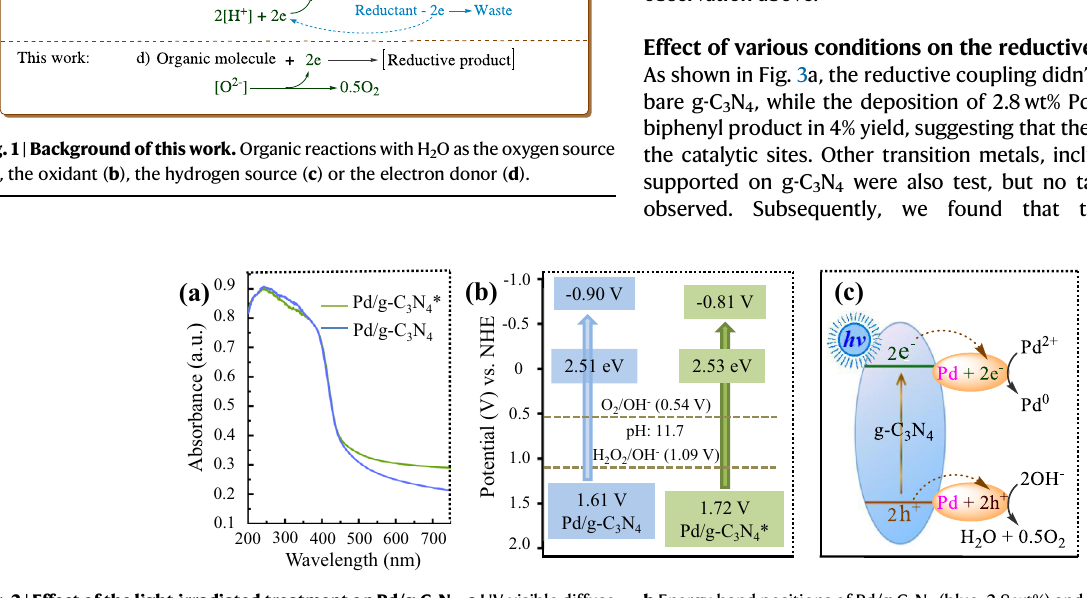
Fig.2|Effectofthelight-irradiatedtreatmentonPd/g-C 3 N 4 .a UV-visiblediffuse re fl ection spectra of Pd/g-C 3 N 4 (blue curve, 2.8wt%) and Pd/g-C 3 N 4 * (green curve, 2.8wt%). a.u.: arbitrary units. Source data are provided as a Source Data fi le.